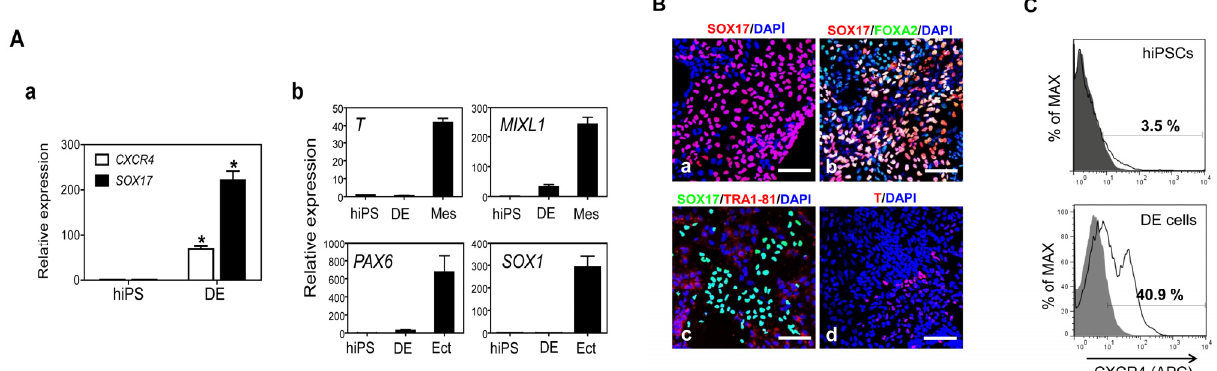
Figure 4. hiPSCs differentiate into DE cells. ( A ) ( a ) Transcriptional expression of the DE marker genes CXCR4 and SOX17 in hiPSC-derived DE cells compared to undifferentiated hiPSCs. Relative expression of marker genes was normalized to GAPDH and fold changes were shown as mean ± SEM ( n = 3, * p < 0.05); ( b ) Determination of differentiation toward other germ layers, such as mesoderm and ectoderm, in the population of DE-induced cells. Expression of mesoderm ( T and MIXL1 ) and ectoderm ( PAX6 and SOX1 ) marker genes was evaluated by q-PCR. hiPSCs (designated as hiPS) was a negative control. Mesodermal (Mes) and ectodermal cells (Ect) were positive controls; ( B ) Immunofluorescence of ( a , b ) DE markers (SOX17 and FOXA2); an ( c ) undifferentiated marker (TRA1-81); and a ( d ) mesodermal marker (T) in the DE cells. Scale bar = 200 μ m; ( C ) Flow cytometry analysis for expression of the DE marker CXCR4 in hiPSCs and hiPSC-derived DE